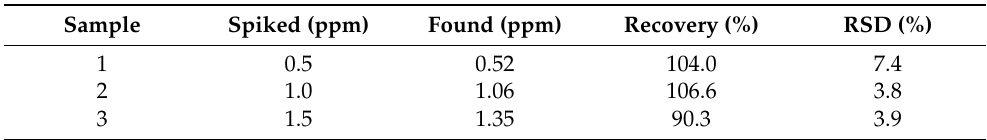
Table 2. Recoveries for detecting dimethoate with the proposed assay in drinking water samples. ( n = 3). Sample Spiked (ppm) Found (ppm)